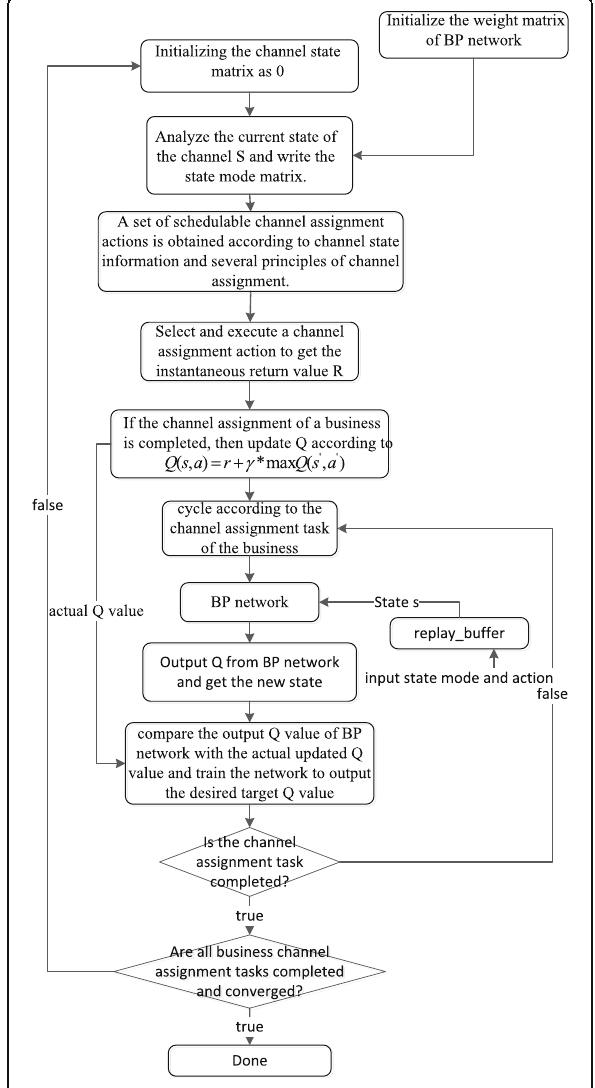
Fig. 2 Flow of the intelligent channel allocation